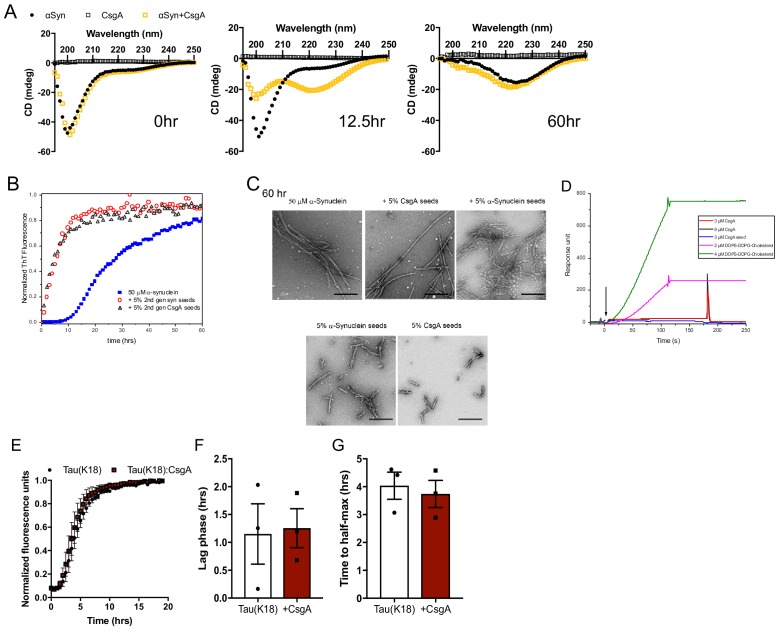
CsgA seeds αSyn aggregation and propagation in vitro.(A) Circular dichroism spectroscopic analysis of αSyn fibrilization alone or in the presence of CsgA at 0, 12.5, and 60 hr post-aggregation. (B) Thioflavin T fluorescence during αSyn amyloid formation alone or in the presence of 5% seeds previously generated by addition of CsgA monomer to αSyn (as in Figure 2a) or αSyn alone. (C) Transmission electron micrograph of fibril structures generated by the addition of above seeds and of seeds themselves. (D) Surface plasmon resonance measurements of surface immobilized αSyn with additions of either CsgA monomer or seeds, or DOPS-DOPG cholesterol liposomes as positive control. (E) Amyloid aggregation as measured by Thioflavin T fluorescence with Tau alone or in the presence of CsgA monomers (25:1 molar ratio, red). Time to reach (F) exponential fibrilization/lag phase and (G) half-maximum from reactions in (E).Figure 3—figure supplement 1—source data 1.Source data and statistical analysis.